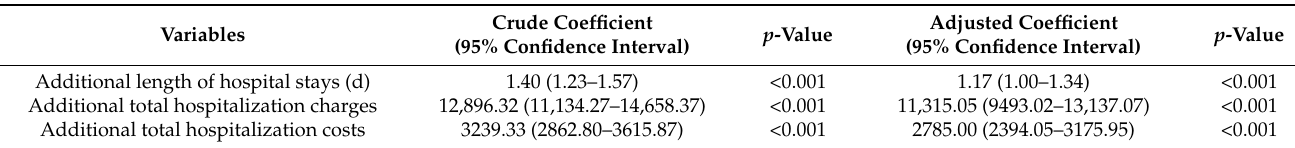
Table 3. Univariate and multivariable logistic regression model showing effect of AKI on resource utilization in rhabdomyolysis-related